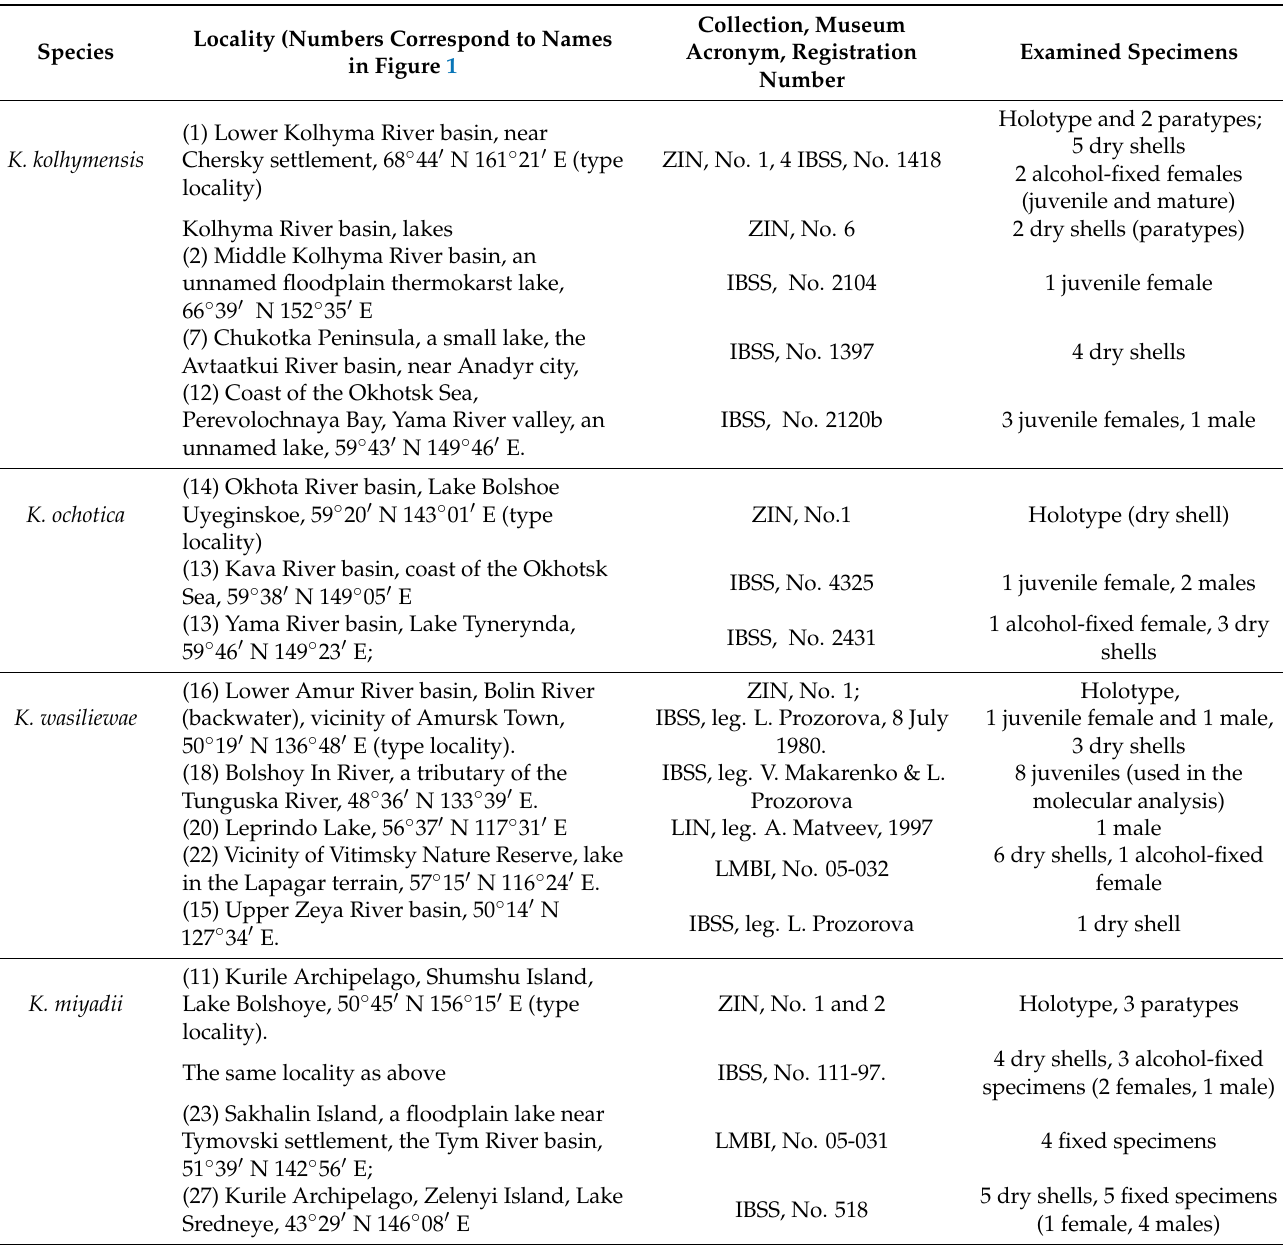
Table 1. List of the studied material, including museum lots and new samples obtained during this